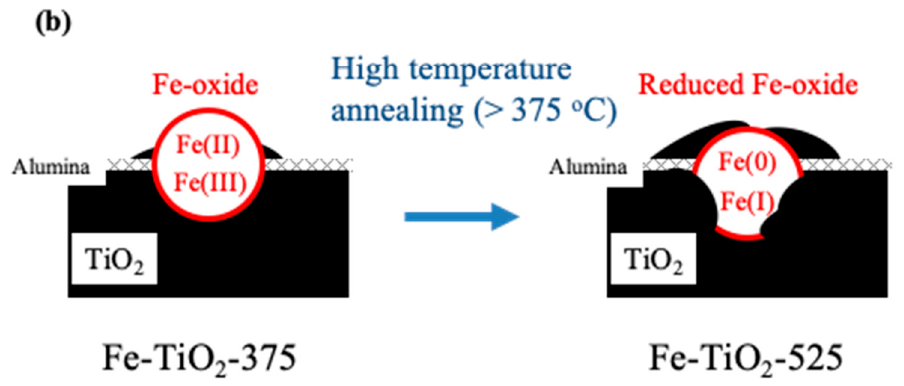
Figure 6. The suggested scenario. Schematic depictions of ( a ) the suggested scenario that explains the surface structure changes associated with higher temperature annealing and ( b ) the annealing temperature dependency of the photocatalytic activity of the Fe-TiO 2 sample.